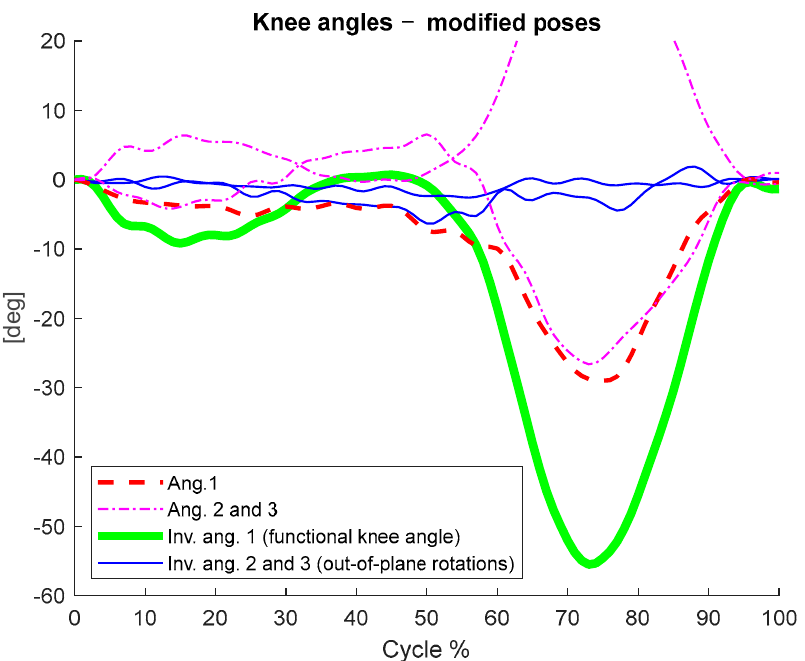
Figure 2. The anatomical angles calculated after applying a random transformation on the measured poses (corresponding to a change in femur and tibia CSs) and the respective invariant angles calculated based on the same modified poses. Table 1. Ranges of motion of the anatomical angles and the invariant angles in the cases of original poses and modified poses.